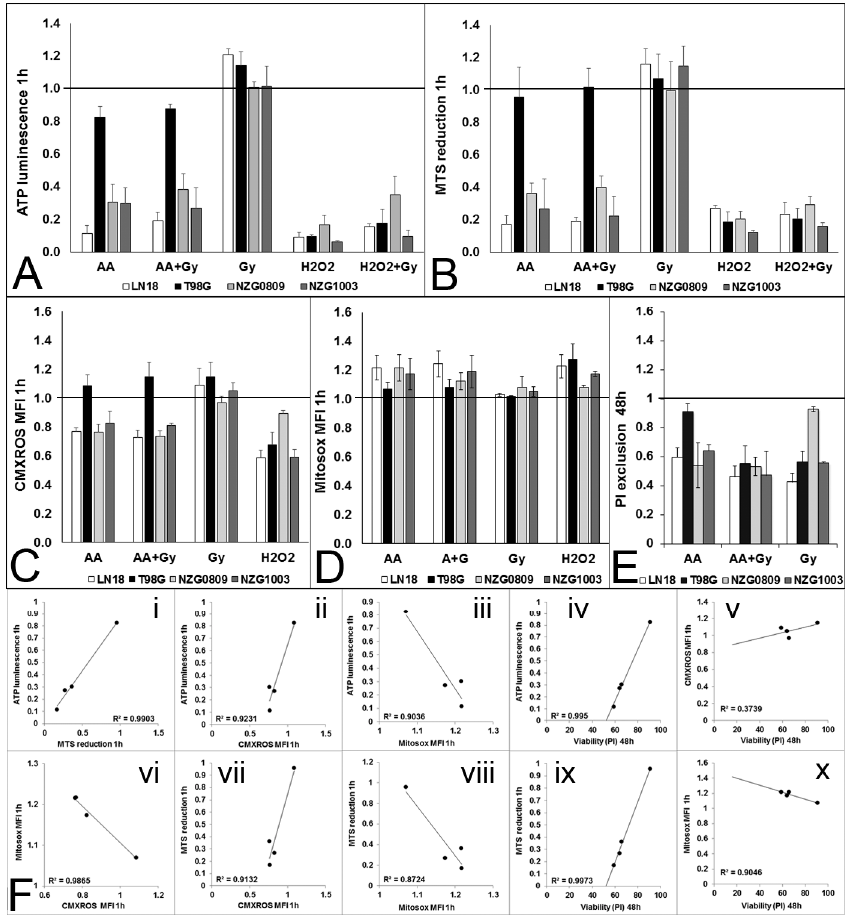
Figure 5. Metabolic stress after 1 h exposure to 5 mM AA, 6 Gy, 5 mM AA + 6 Gy and 500 µM H 2 O 2 compared to untreated controls (set at 1). ( A ) Cellular ATP levels measured by